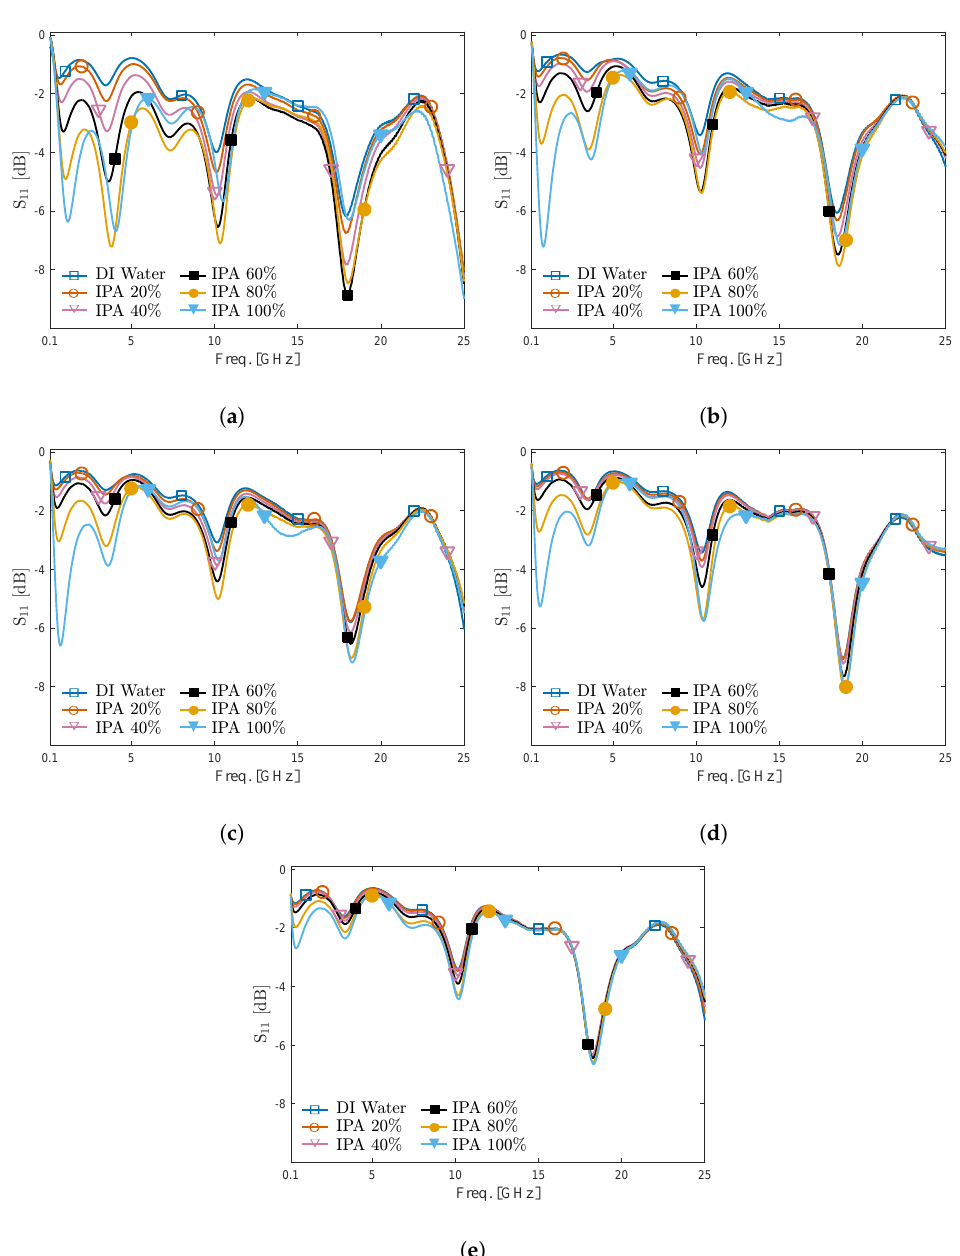
Figure 6. Measured reflection coefficient S 11 for the mixture of deionized (DI) water and Isopropanol (IPA) with different concentrations and with IDCs having different electrode widths and separation between electrodes. Electrode width and separation between electrode both ( a ) 10 µ m, ( b ) 5 µ m, ( c ) 4 µ m, ( d ) 3 µ m, ( e ) 2 µ